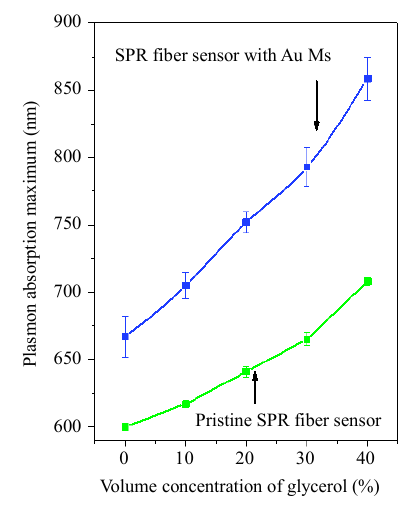
Fig. 6 Dependence of resonance wavelength on volume concentration of water/glycerol for pristine SPR fiber sensor and sensor with grated